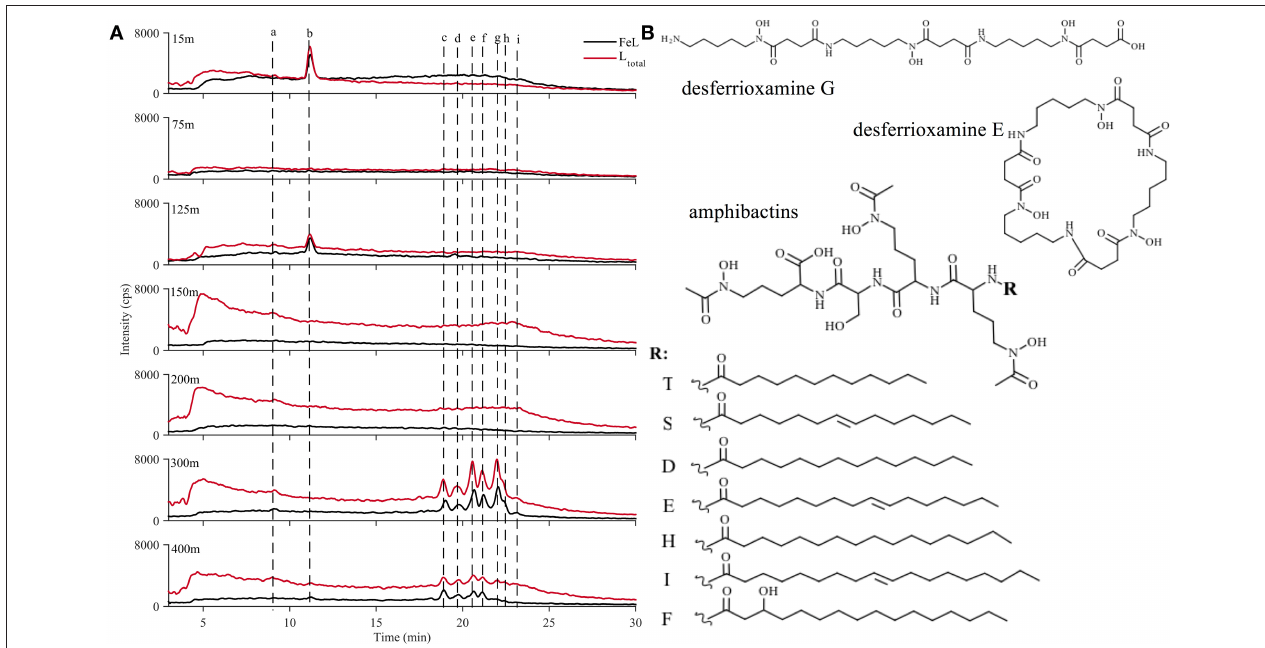
FIGURE 2 | (A) 56 Fe ICP-MS chromatograms from 15m (top) to 400m (bottom) where black represents the iron-bound ligands and red represents the total ligand concentration after an iron addition to the extract. (B) Structures of desferrioxamine G (peak a ), E (peak b ) and amphibactins (T, S, D, E, H, I, F; peaks c–i ) identified in the water column at Station ALOHA.